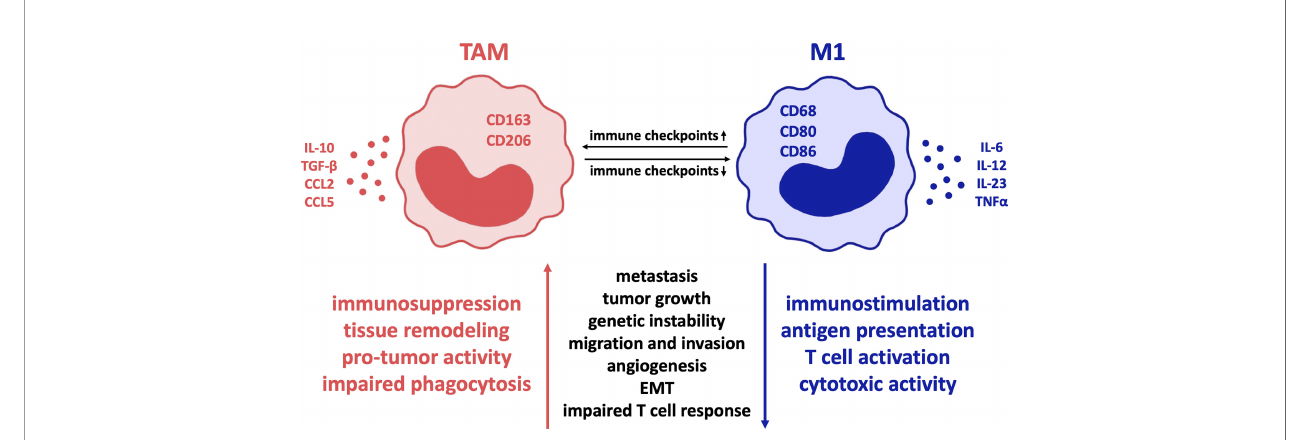
FIGURE 1 | In fl uence of co-regulatory immune checkpoint molecules on macrophage polarization in cancer. In various malignant diseases, the expression of such co-receptors is proven to alter tumor-associated macrophages towards the so-called M2 immune pro fi le with reduced in fl ammation and thereby mostly “ pro-tumor ” activity. In contrast, minor expression of immune checkpoints correlates with the M1 macrophage type, characterized by cytotoxic immune cell activity and improved phagocytic ability that results in signi fi cant disease clearance. Therefore, inhibition of immune checkpoint expression on macrophages is a highly promising treatment strategy in cancer pathologies. Regarding colorectal cancer, pancreatic cancer and glioblastoma, predominantly PD-1 and CD47 are of great relevance and offer promising targets for checkpoint inhibition. Though, due to the fact that macrophages in different diseases are characterized by expression of different immune checkpoints, the importance of individual therapeutic approaches is highlighted. TAM, tumor-associated macrophages; EMT, epithelial mesenchymal